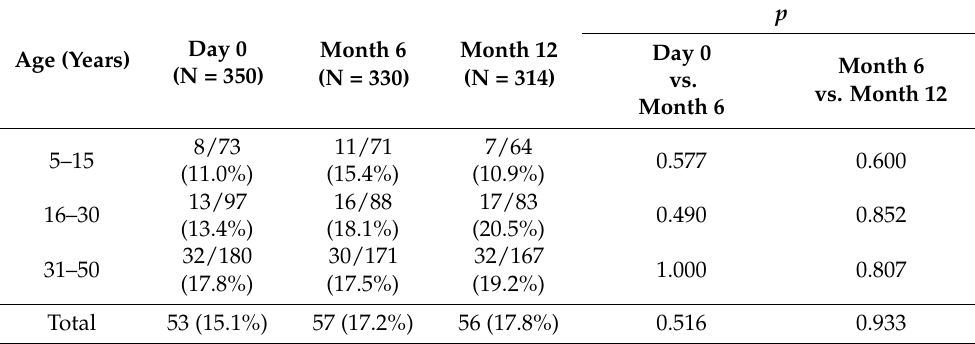
Table 2. The number (%) of subjects who had Zika virus nonstructural protein 1 seropositivity by age group and